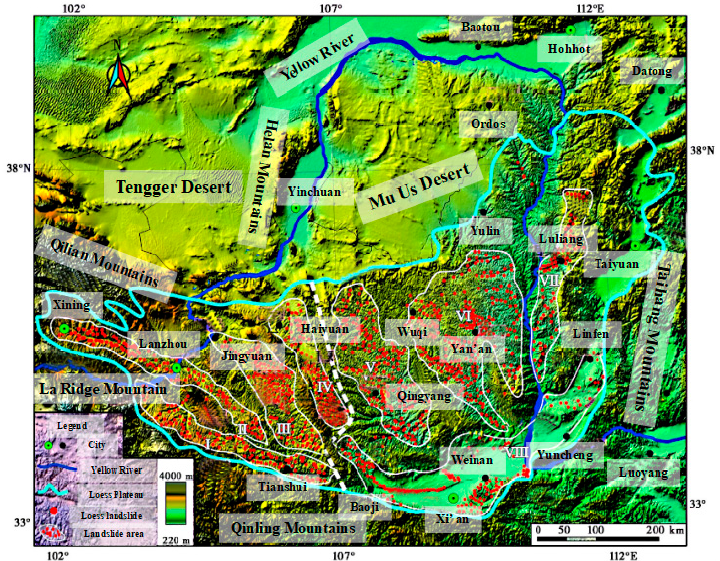
Figure 1. Spatial distribution of landslides in the Loess Plateau of the Yellow River Basin [8].